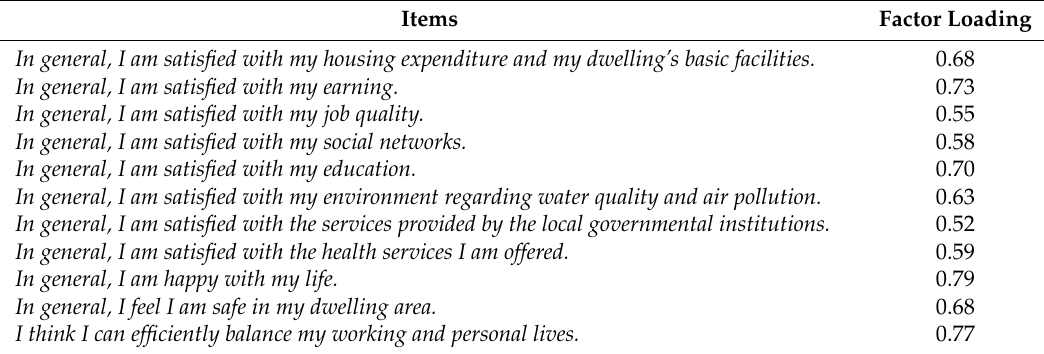
Table 8. Final items of the life satisfaction (LS) scale and their standardized factor loadings. Items Factor